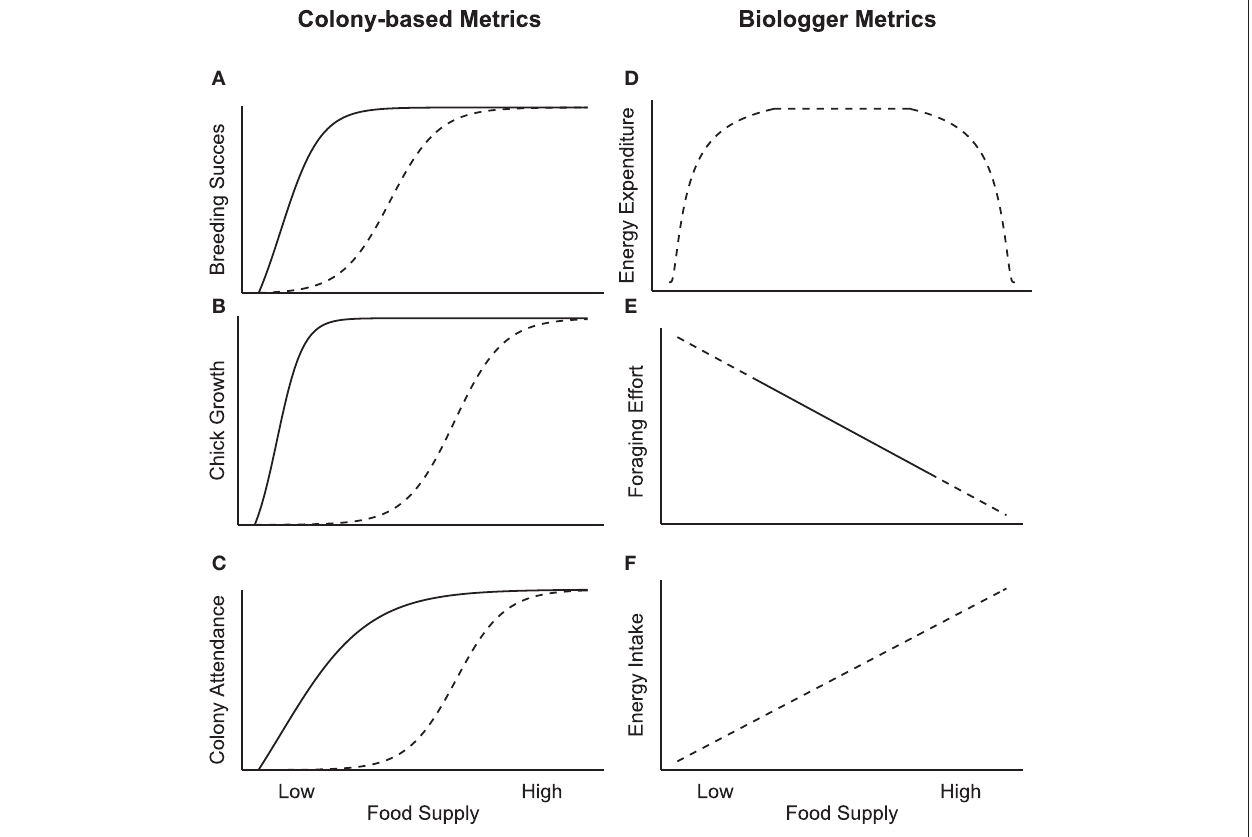
FIGURE 1 | Theoretical (dashed lines) and observed (solid lines) relationships between food supply and colony-based parameters ( A–C ; adapted from Cairns, 1987) or biologging parameters (D–F) . Cairns’ original parameters are sensitive to low food supply, while biologging parameters are theoretically sensitive to a broader range of food